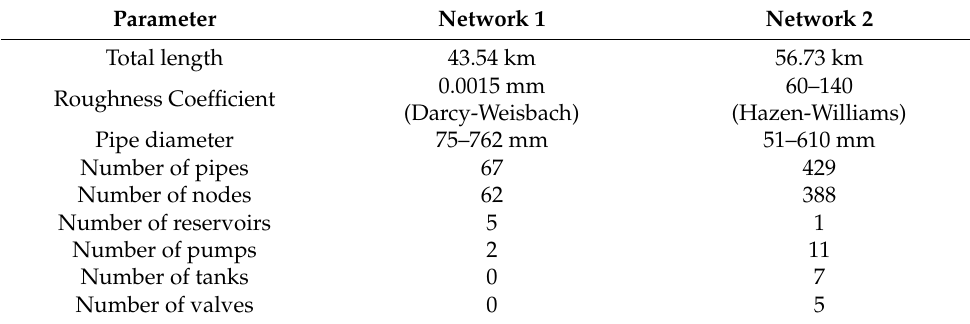
Table 1. Main characteristics of the elements of the case study